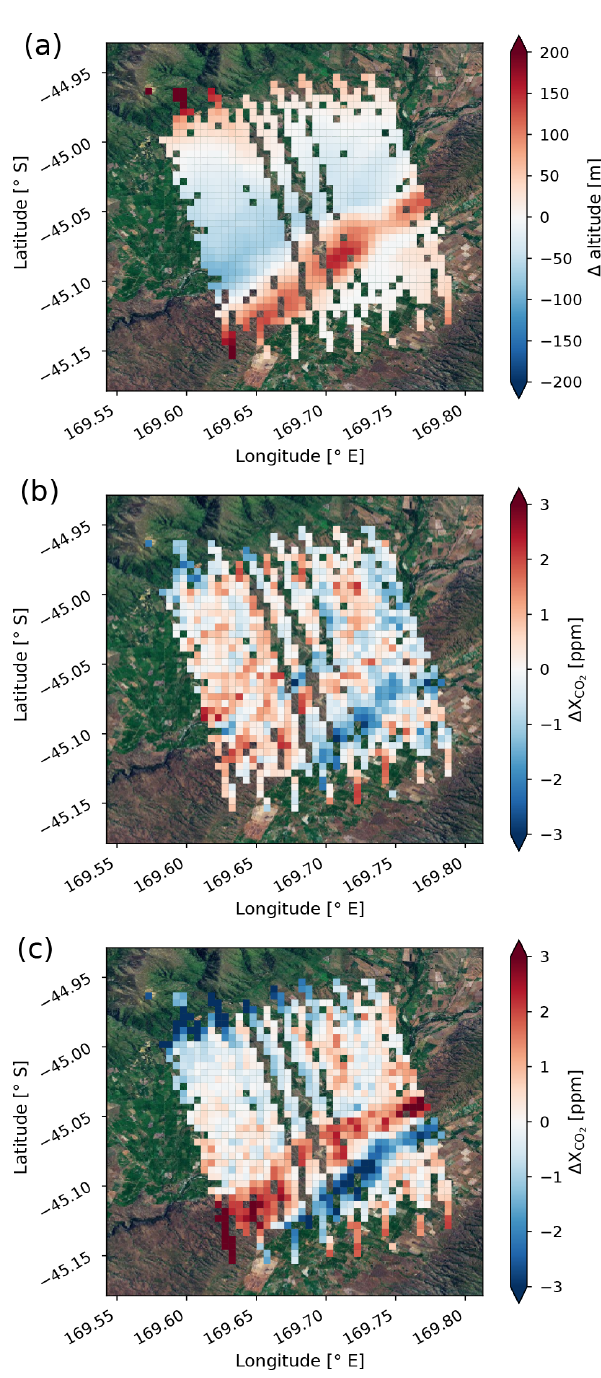
Figure 1. OCO-2 target mode observation over Lauder, New Zealand, on 17 February 2015. Panel (a) shows (cid:49) altitude (defined as the sounding altitude minus the median altitude of all soundings in the given latitude and longitude limits). Panels (b) and (c) show the variation of raw and bias-corrected OCO-2 v8 (cid:49) X CO in the same way as (cid:49) altitude) after applying the v8 filters. In- dividual soundings are aggregated into 0.005 ◦ × 0.005 ◦ latitude– longitude square